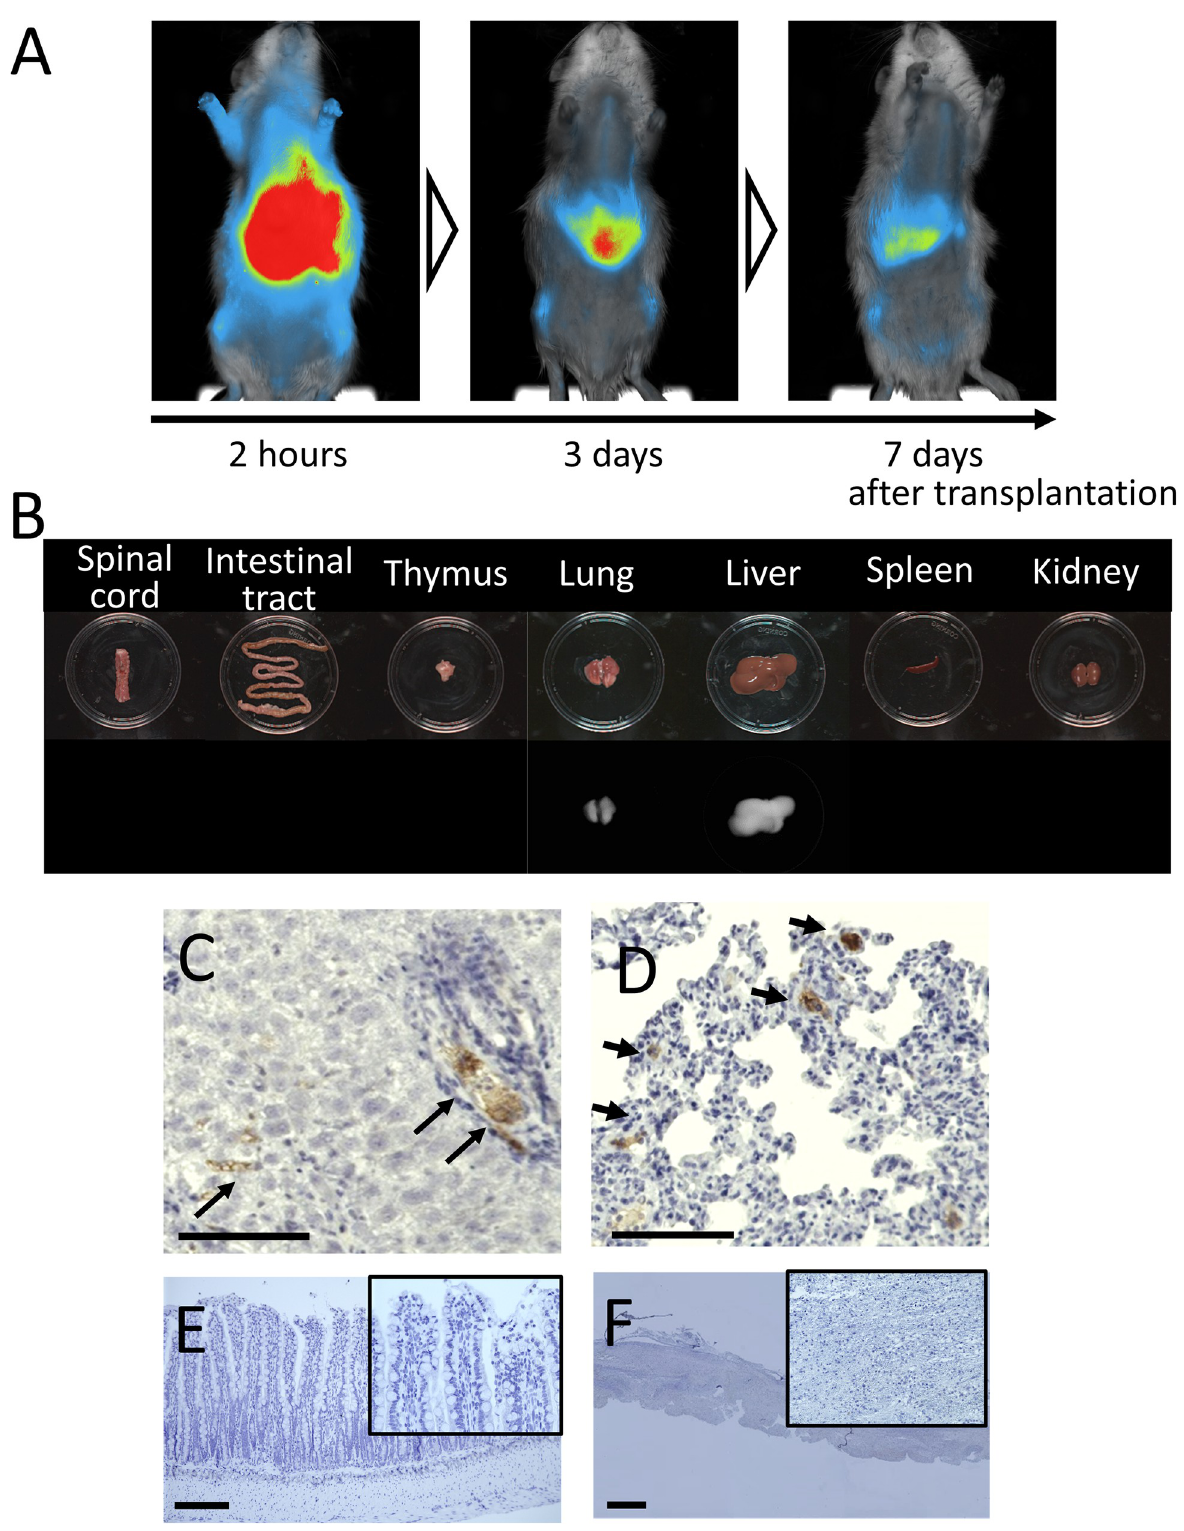
Fig 2. Transplanted AMSCs were mainly distributed in the liver and lung. (A) In vivo imaging was conducted to evaluate the distribution of the infused AMSCs. Fluorescence from the XenoLight DiR labeled AMSCs was detected 2 h, 3 d, and 7 d after transplantation. Most of the signals were